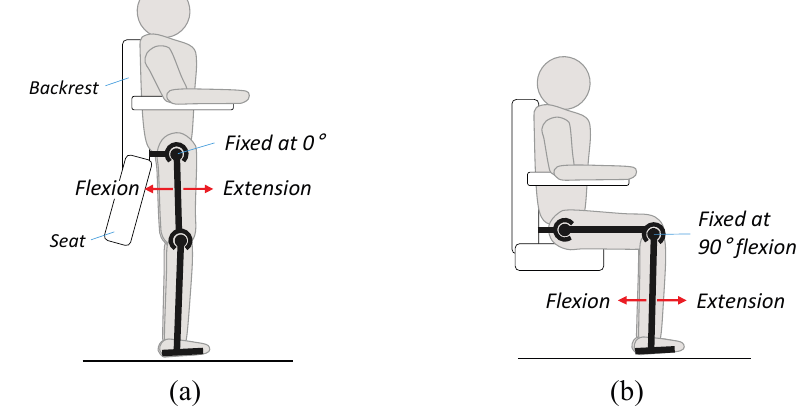
Figure 7. Schematic representation of the isometric calibration procedure. ( a ) Isometric hip flexion and extension; ( b ) Isometric knee flexion